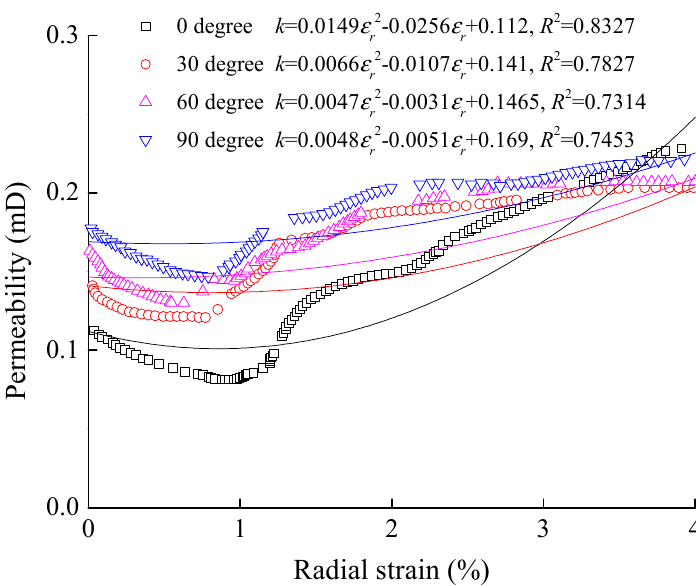
Figure 9. Fitting of permeability–radial strain data of coal samples with different bedding angles.